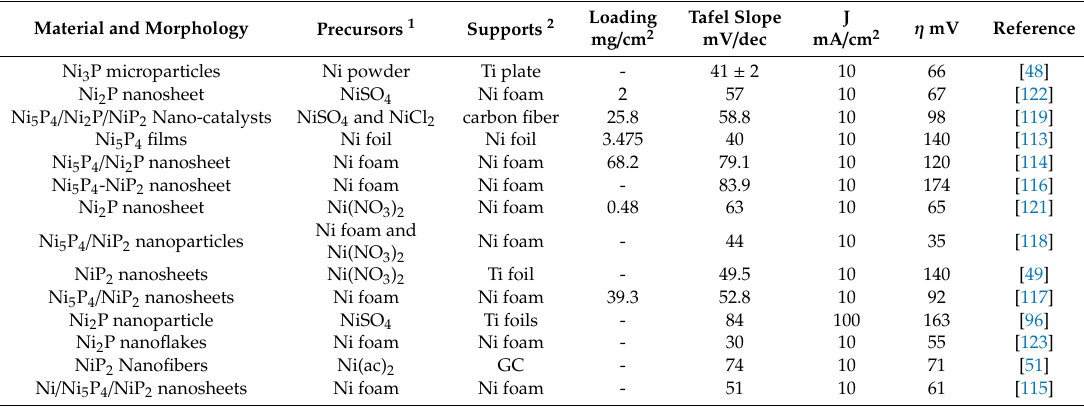
Table 5. Summary of the nickel phosphide electrocatalysts prepared through thermal phosphidation with red phosphorus for HER in an acidic